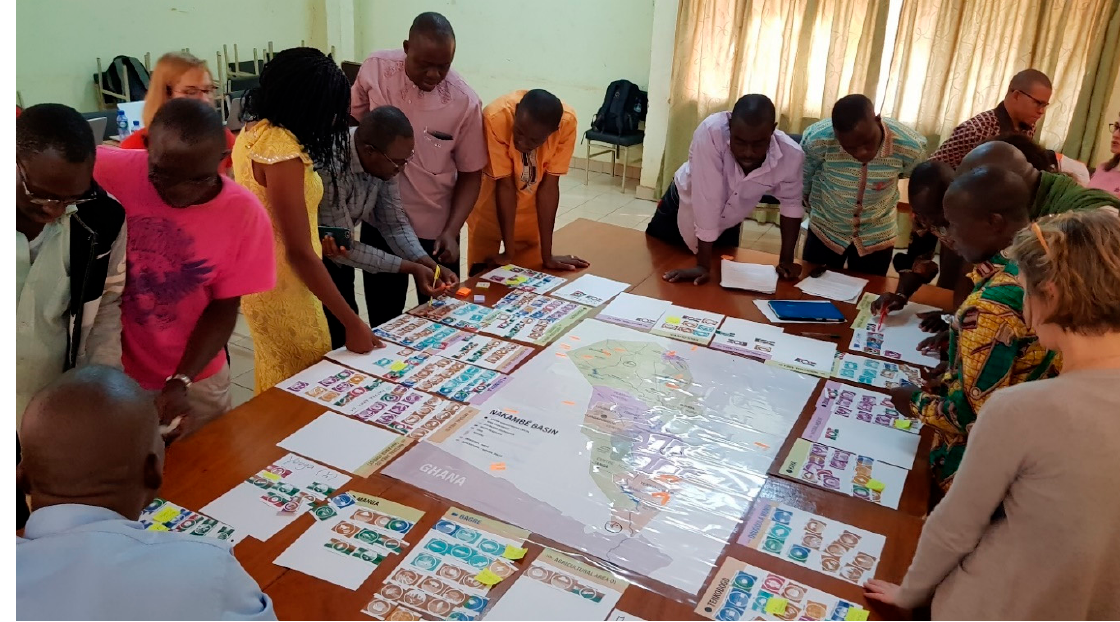
Figure A1. Participants describing the current situation of Nakambe Basin, during the strategic simulations in Ouagadougou.